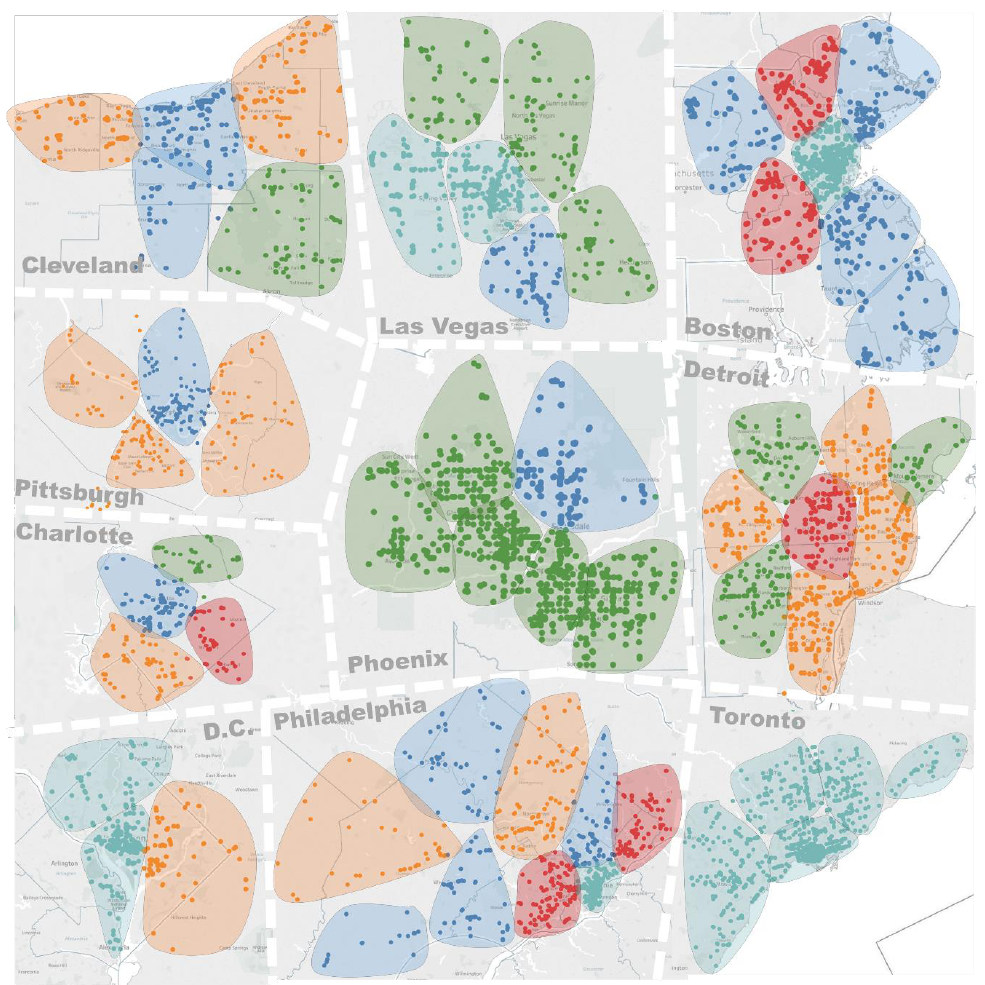
Figure 11. Cultural interactions between different cities. Similar colors across cities indicate similar tastes.